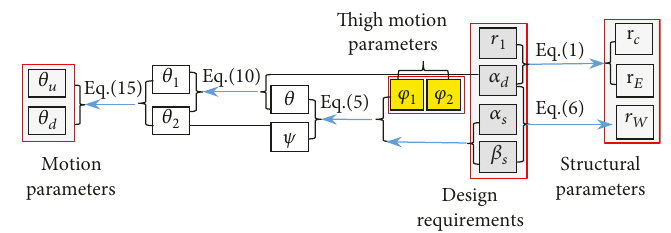
Figure 8: Computation procedure.